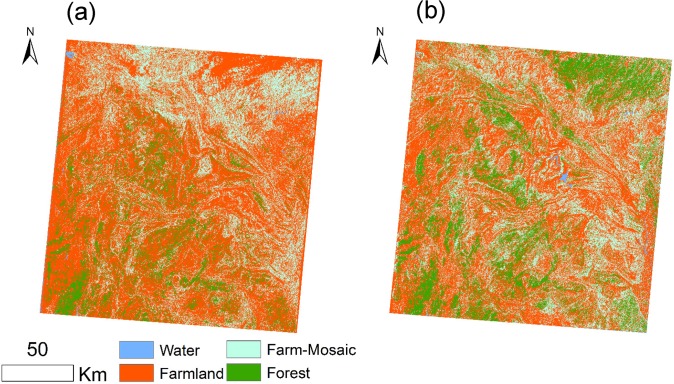
The land use change of the typical area with the significant EVI increase in 2002 (a) and 2010 (b).It locates the boundary area among Sichuan, Yunnan and Guizhou.